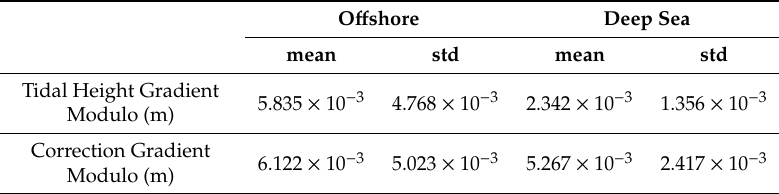
Figure 8. Tidal height gradient modulos, the corresponding tidal positioning correction gradient modulos and their fittings of the o ff shore and the deep sea segments. Table 2. Tidal height gradient modulo and the corresponding tidal positioning correction modulo of o ff shore and deep sea